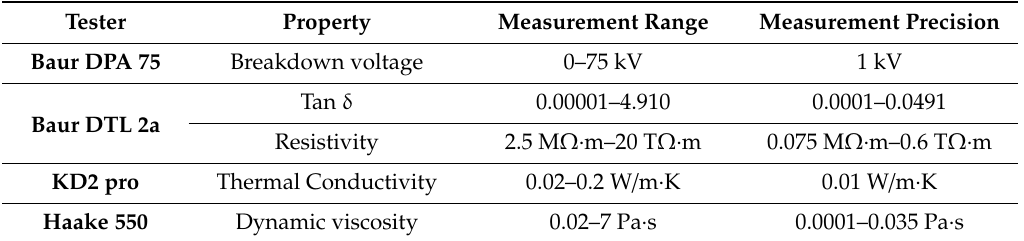
Table 2. Measurement range and precision of the testers employed during the